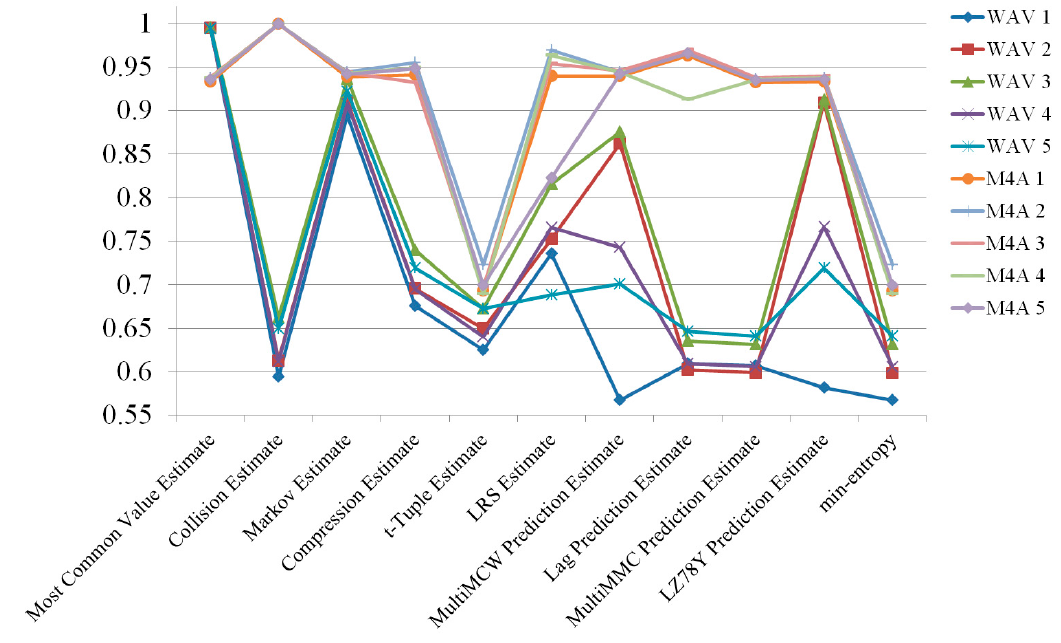
Figure 7. Randomness estimation results of radio signals collected with 2 s delay.